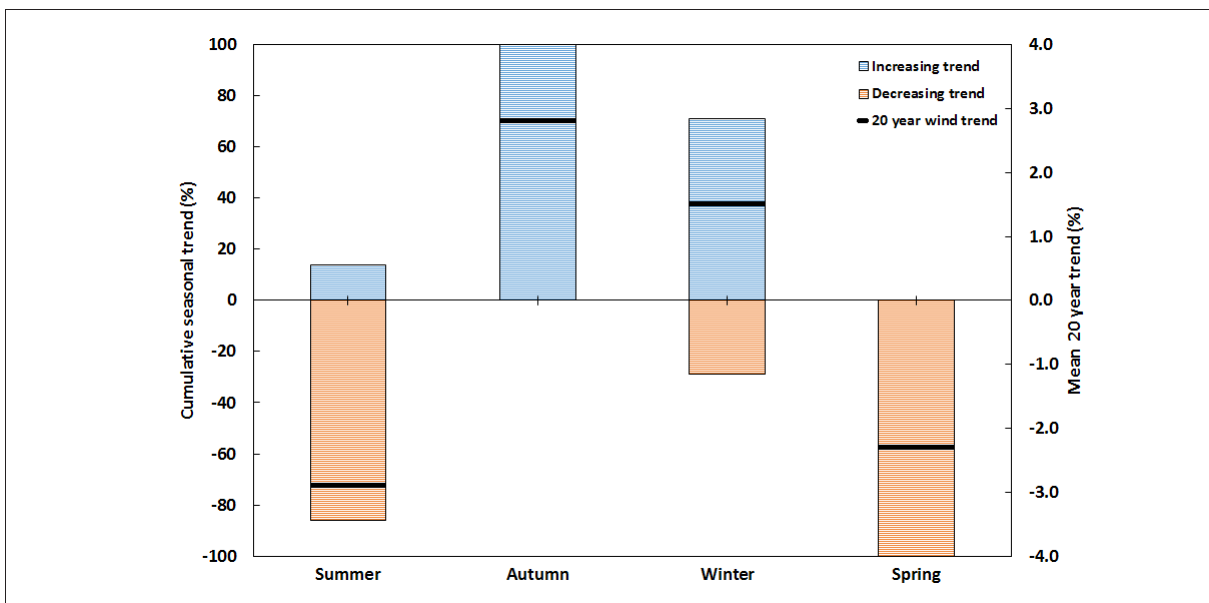
Figure 6: Mean seasonal wind speed trends for the period